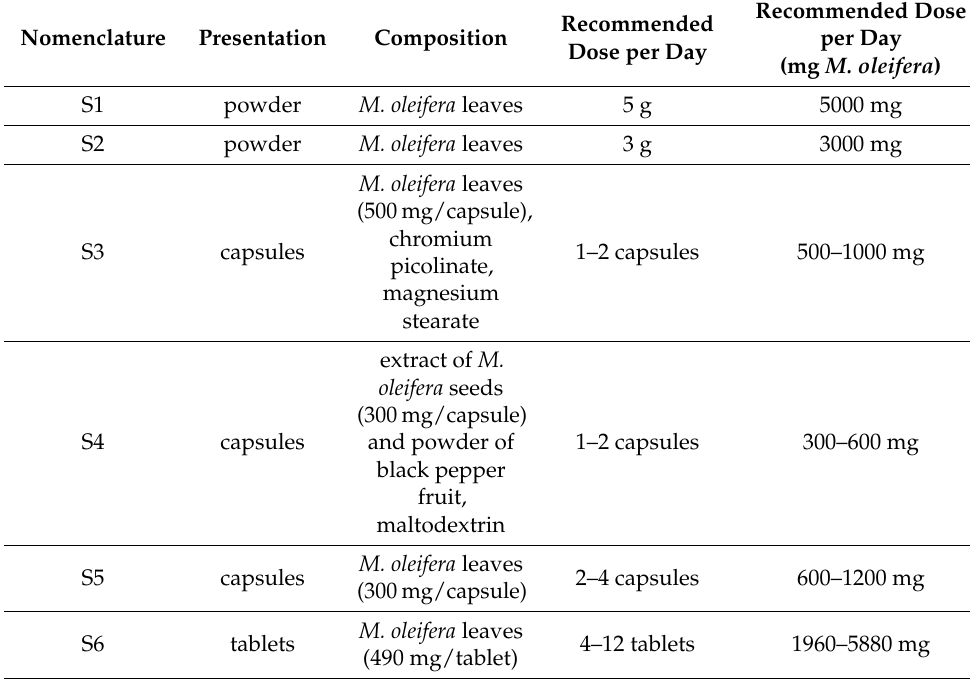
Table 1. Nomenclature used and data for each food supplement of M. oleifera